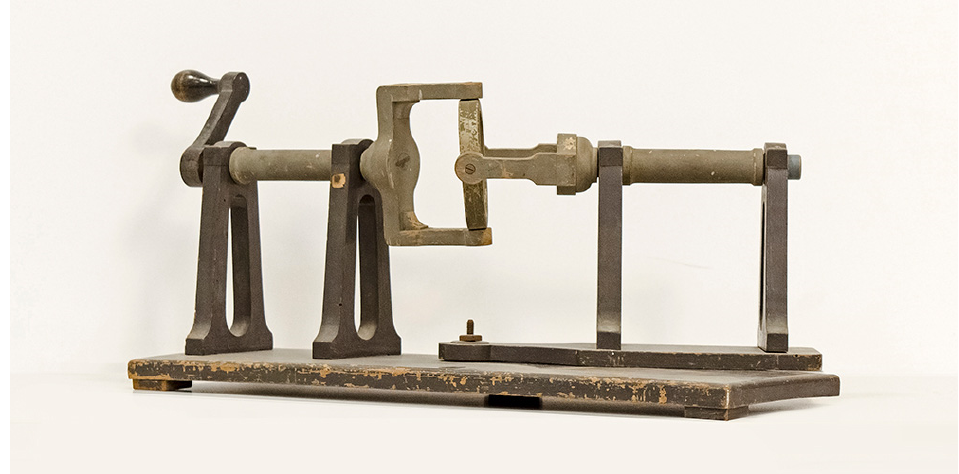
Figure 22. An example of the on-site built mechanism models at University of Palermo.